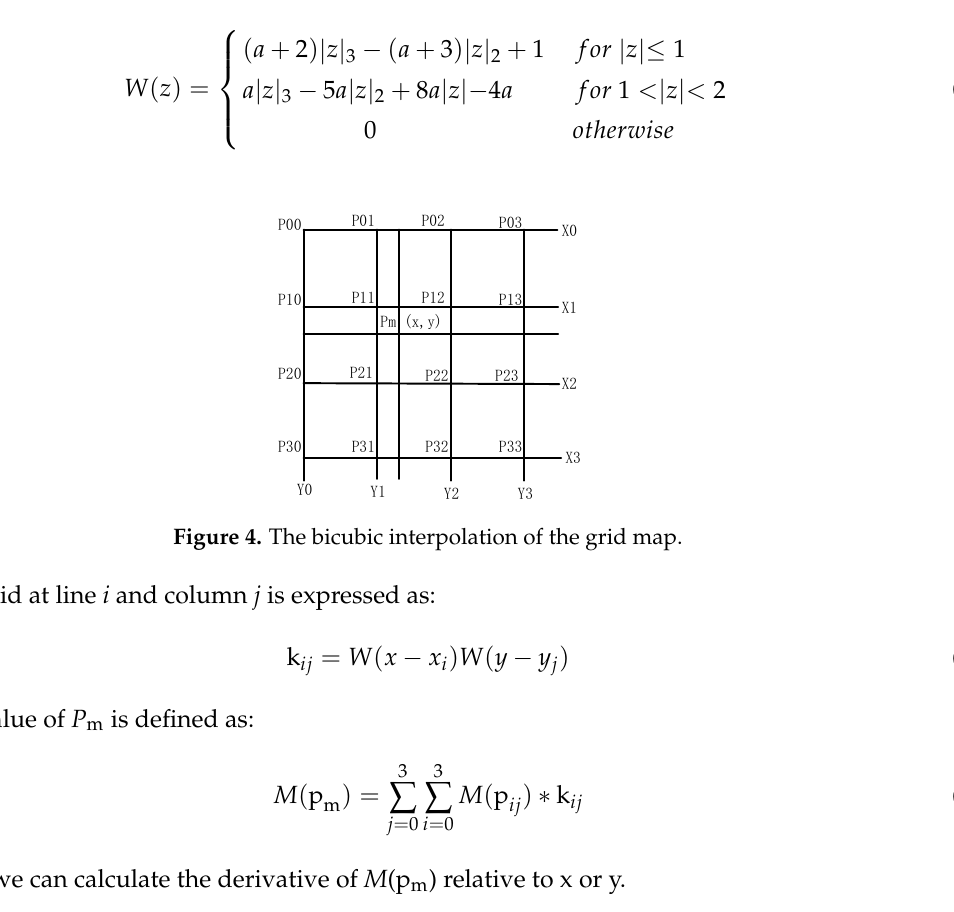
Figure 3. Simulation comparisons of map updating between the proposed strategy and the existing one.